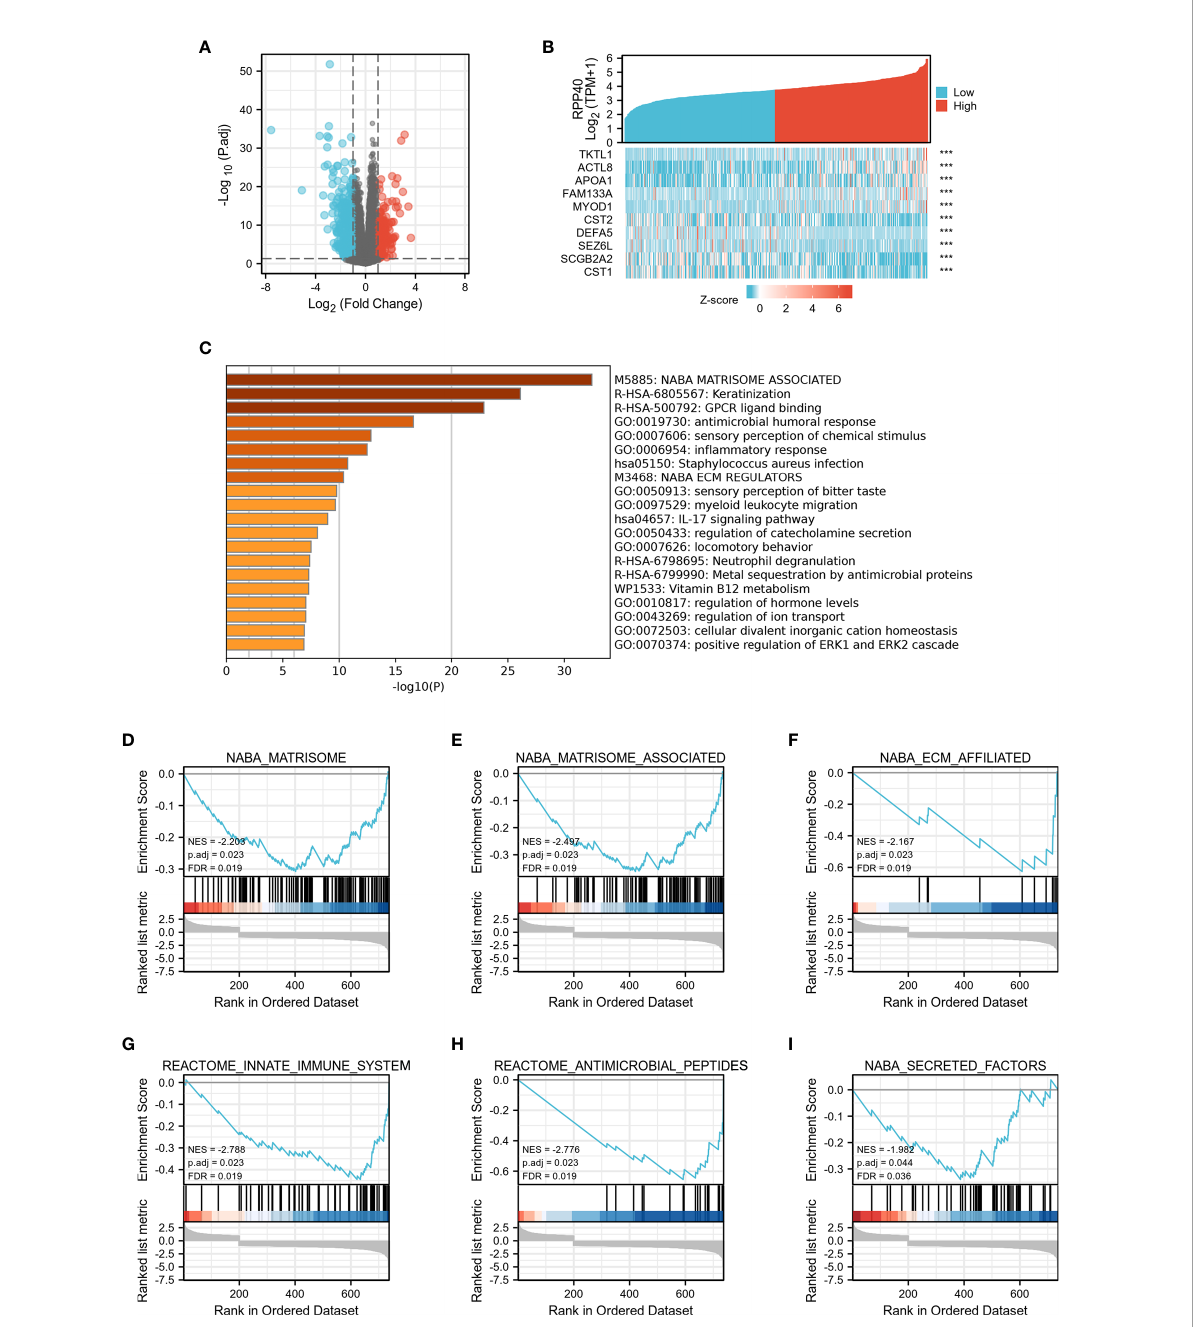
FIGURE 8 Identi fi cation and functional enrichment analysis of DEGs in UCEC patients with distinct RPP40 mRNA levels. The mRNAs of DEGs between two groups are presented by volcano plots (A) , and represented DEGs are shown as heatmaps (B) . Statistically enriched terms identi fi ed by the Metascape database are shown; the threshold of kappa score is set as 0.3; *** P < 0.001 (C) . Gene set enrichment analysis (GSEA) of differentially expressed mRNAs between high- and low-RPP40-expression groups in UCEC tumors has been conducted, and representative clusters are shown (D-I)